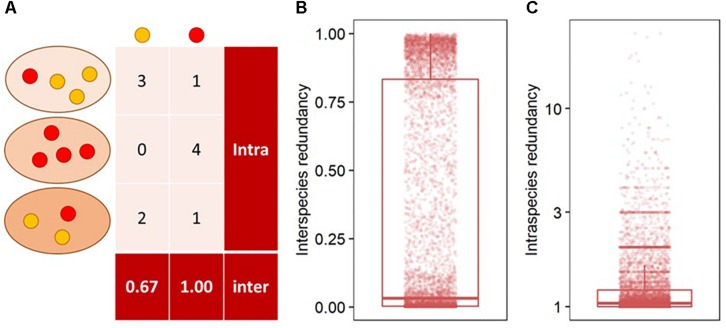
The distribution of interspecies functional redundancy as the total share of functions within fungi relative to the total number of fungal species in the database and intraspecies functional redundancy as the number of replicated KEGG functions within one fungal species in the database. As example, two functions in red and yellow are presented in three taxonomically distinct fungi in different shades of orange (A), and the distribution of interspecies (B) and intraspecies functional redundancy (C) in all 377 analyzed fungal genomes.